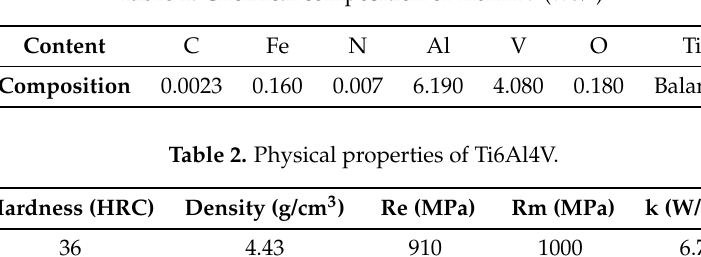
Table 1. Chemical composition of Ti6Al4V (wt%).